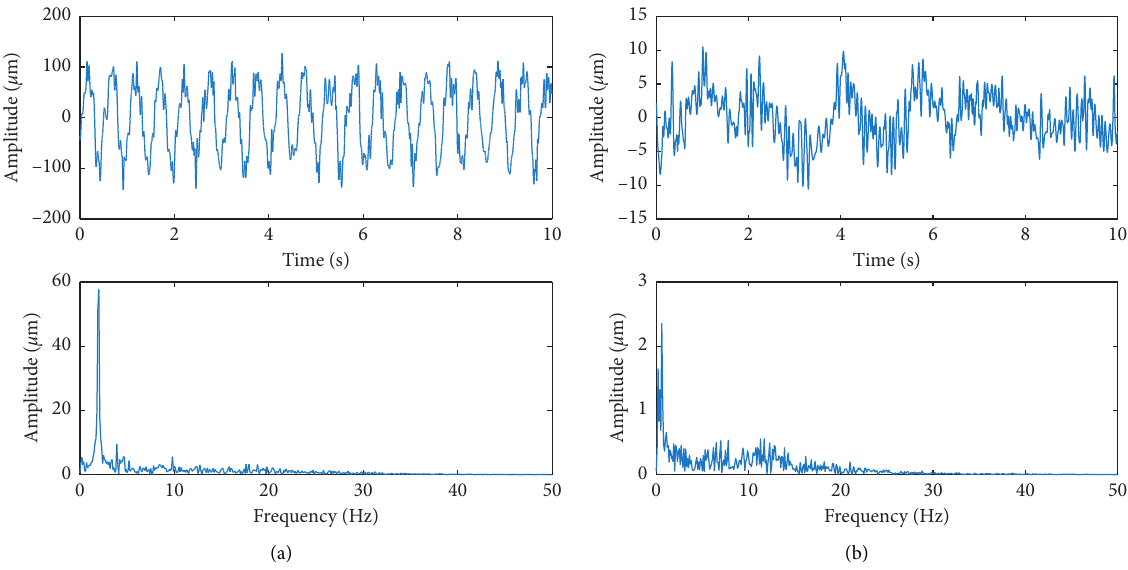
Figure 7: Actual signal processed by EMD. (a) Y -direction swing signal at the flange. (b) Vibration signal at the draft